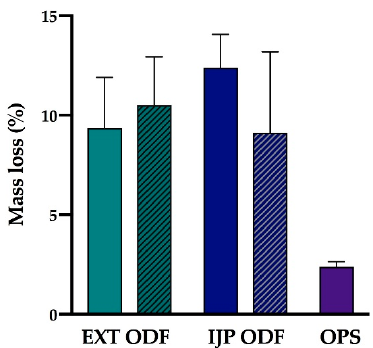
Figure 5. The moisture content reported as mass % weight loss of the sample, for the prepared dosage forms. Results presented as average ± SD, n = 3. Drug-loaded ODFs are shown as colored columns and placebo ODFs are presented as colored columns with a pattern.